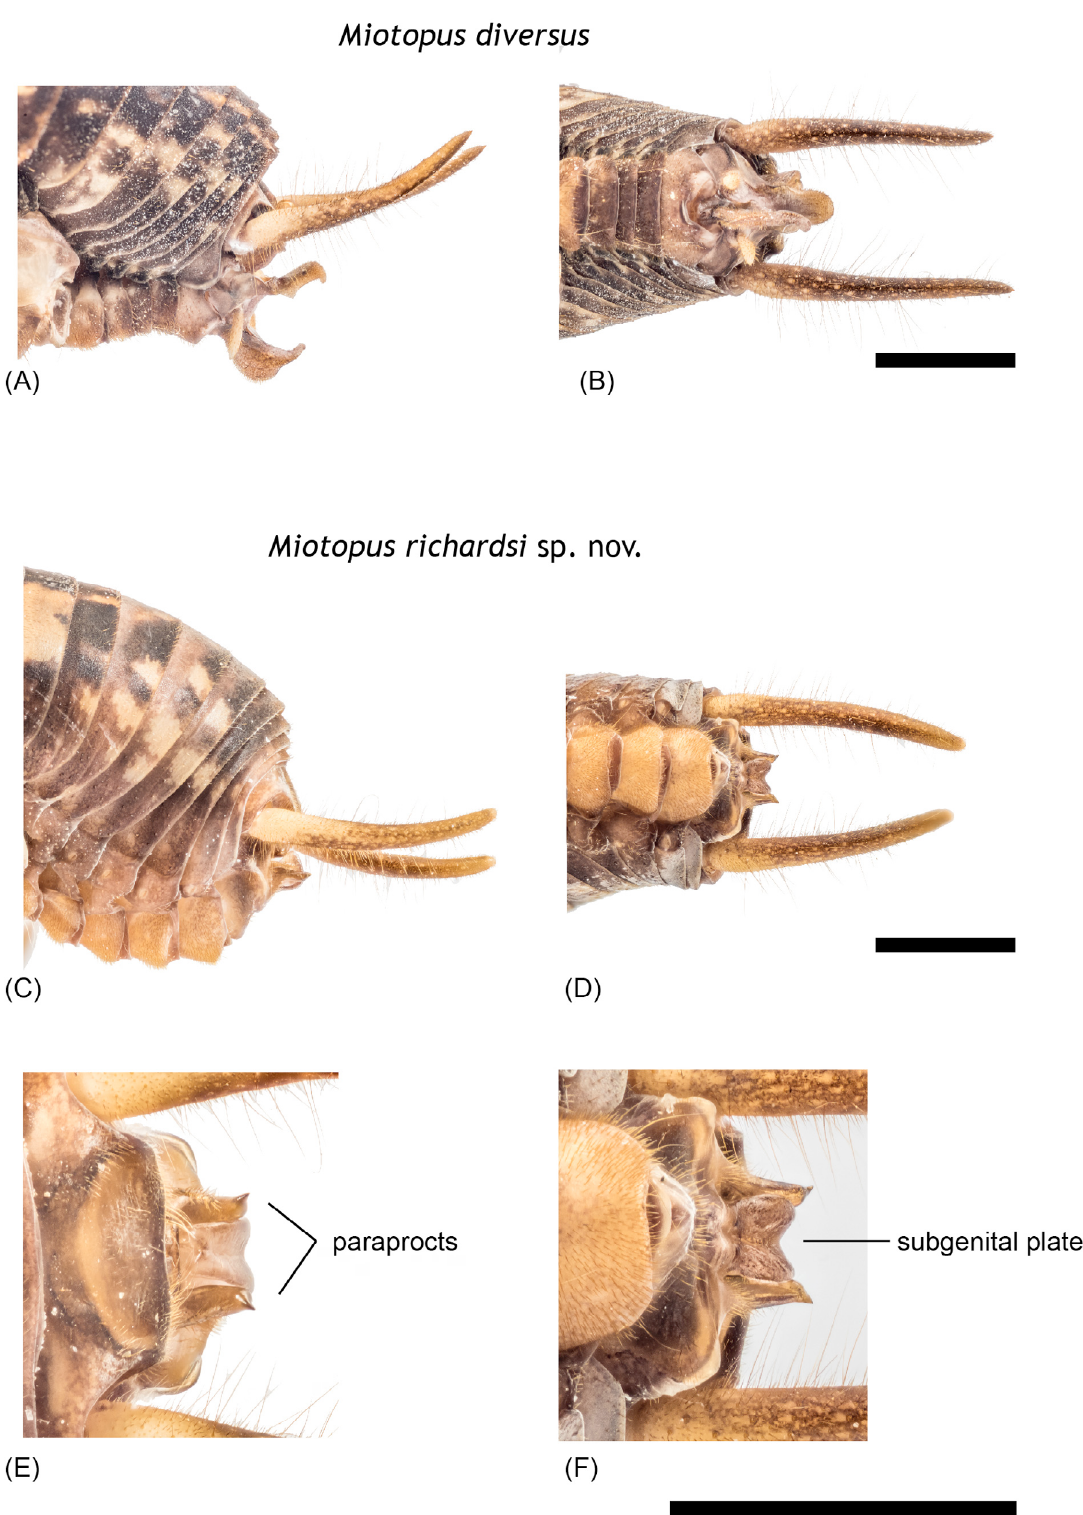
Fig. 7. Male terminalia of Miotopus Hutton, 1898 cave wētā. A–B . Miotopus diversus (hutton, 1896) (MPN Cw3601). A . Lateral. B . Ventral. C–F . Miotopus richardsi sp. nov. (MPN Cw3542). C . Lateral. D . Ventral. E . Close dorsal. F . Ventral views of named structures. Scale bars = 2